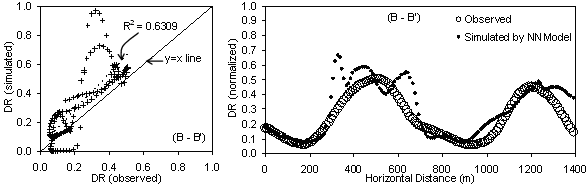
Fig. 11. The observed and simulated damage ratios for cross section B–B 0 .